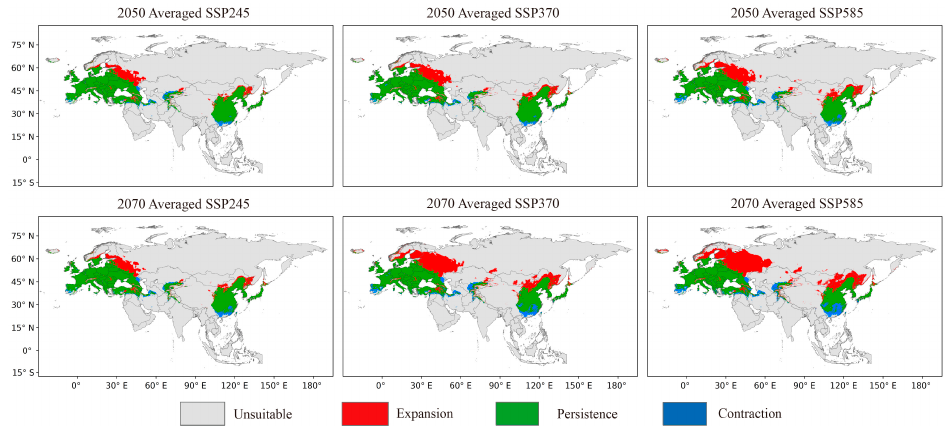
Figure 4. Shift in the O. robiniae average potential distribution range under the three climate change scenarios for 2050 (2041–2060) and 2070 (2061–2080), compared with the current potential distribution (green corresponds to areas of persistence, blue of the contraction zone, and the red is the expansion zone). Spatial resolution: 2.50 min.